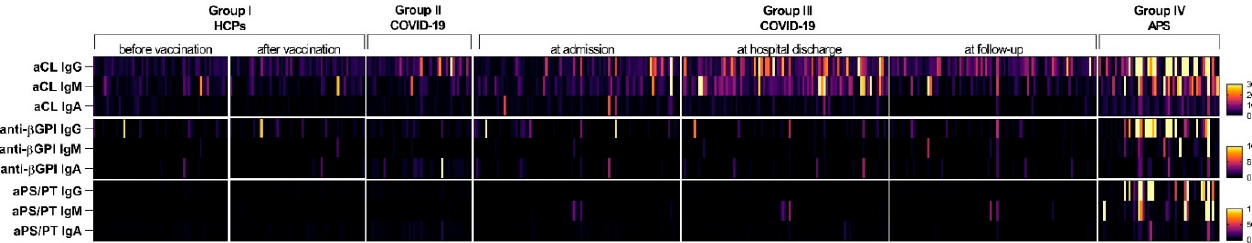
Figure 4. Heatmap showing all results of all participants, separated by tested aPL (vertical) and by groups (horizontal). The legend (colors) represents the titers of each aPL (black represents low levels; yellow represents high levels of each antibody). The results of the same patients are shown in the vertical line. Both HCP groups and all three time points of the COVID-19 group III have the same order of included participants. Therefore, they can be compared directly.